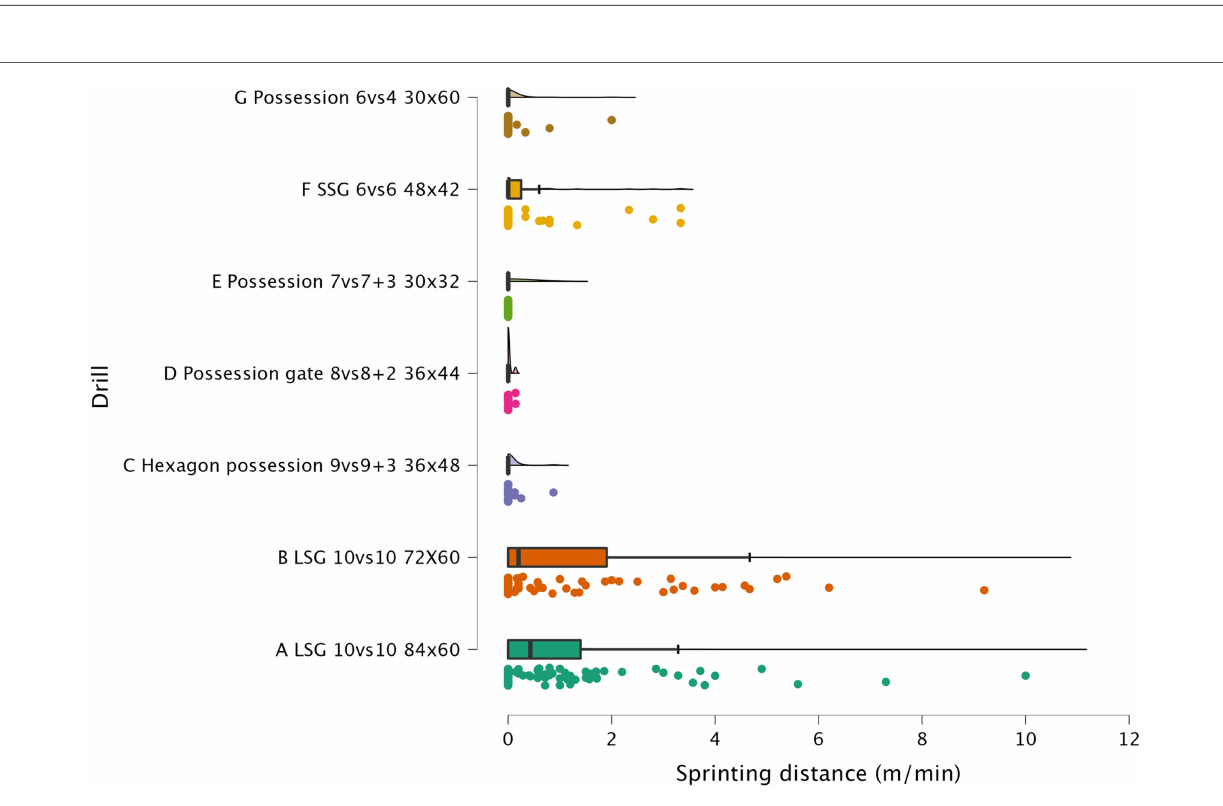
relative space size reduces the distance per minute covered by players (25). A second factor that can affect distance per minute is the rules used during sided-games (7). For instance, Possession